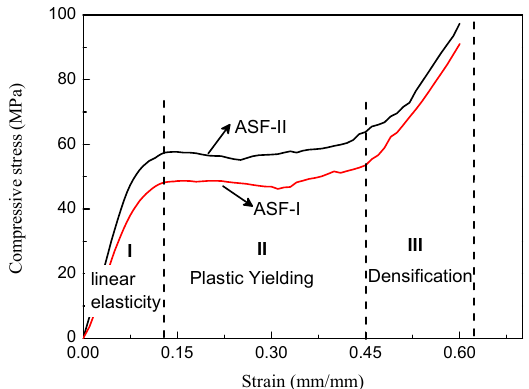
Figure 11. Typical stress–strain curves of the two types of syntactic aluminum foam.